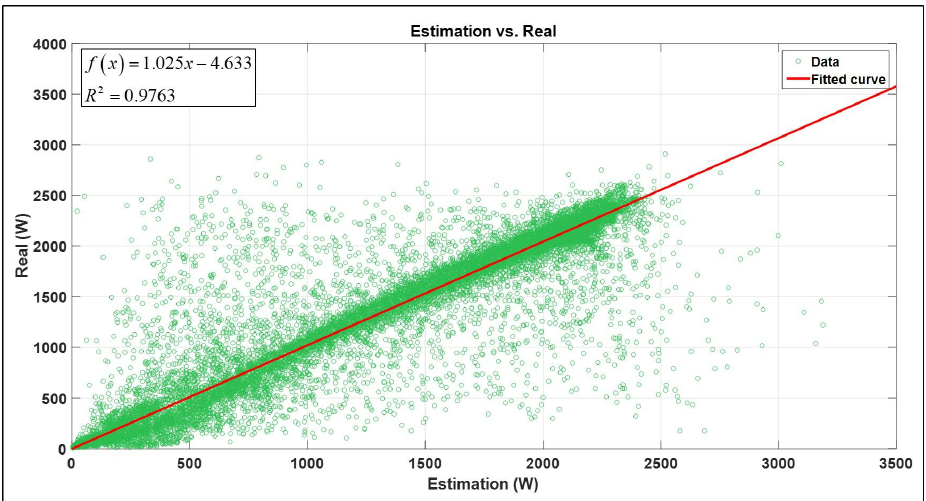
Figure 17. The estimated vs. real photovoltaic power of HS.